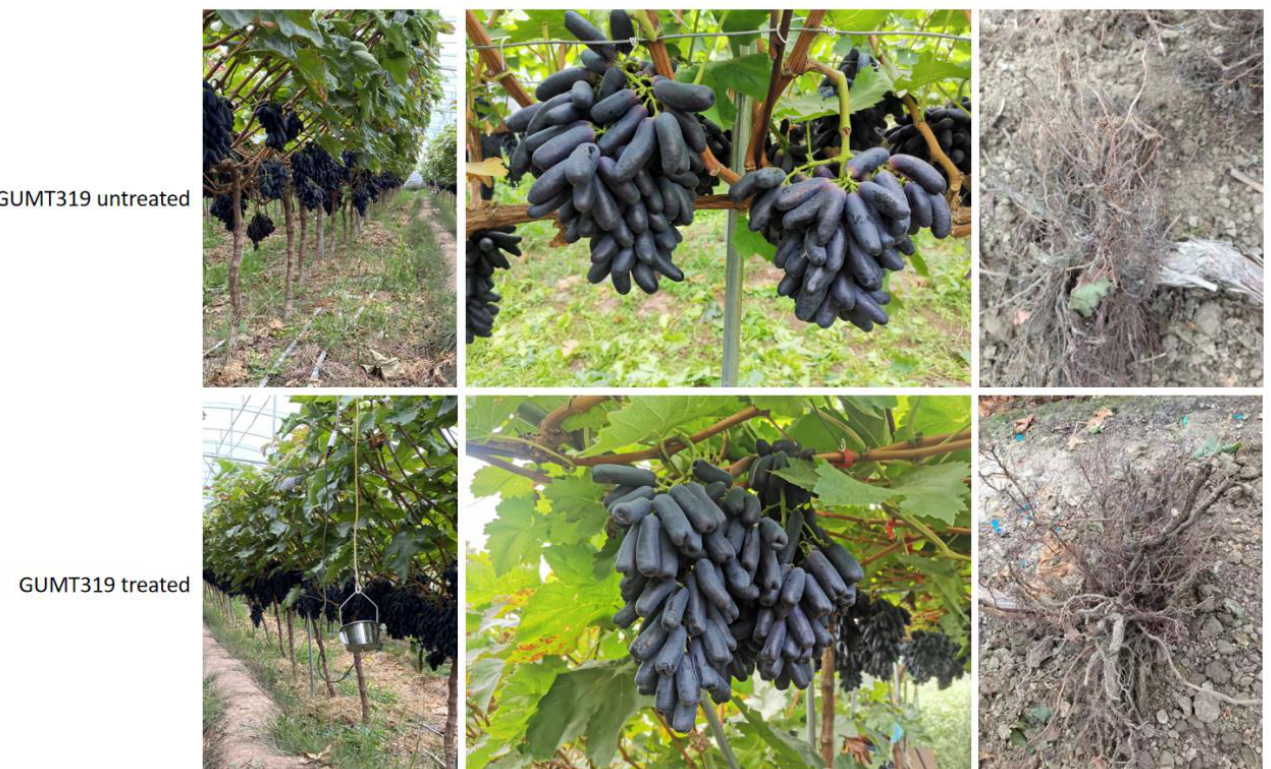
Figure 1. Growth and yield parameters of grape plants treated with and without Bacillus velezensis strain GUMT319.